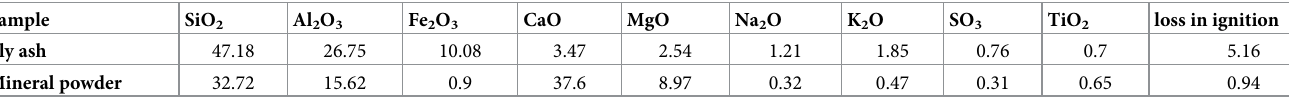
Table 1. The main chemical composition of raw materials.